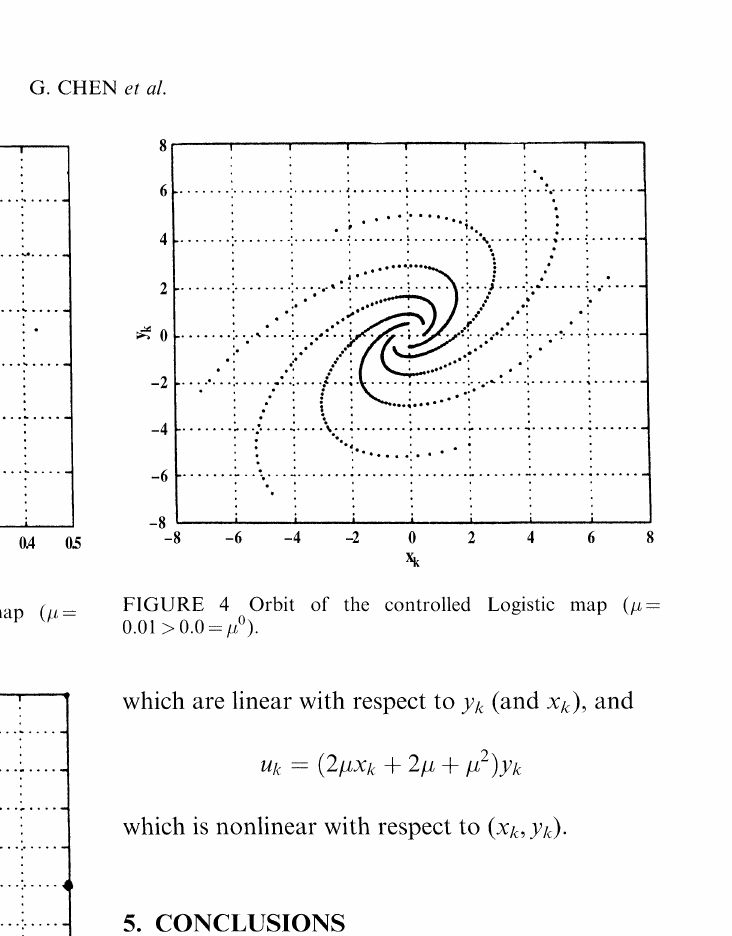
FIGURE 4 Orbit of the controlled Logistic map (#= 0.01 > 0.0 #0).